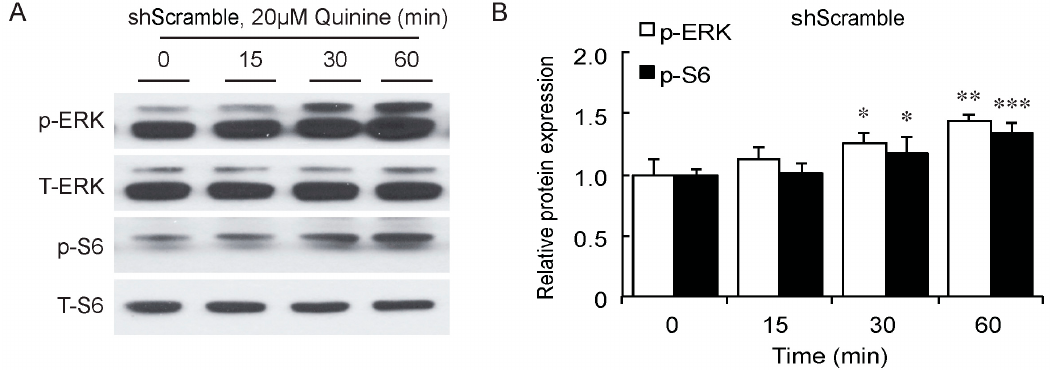
Figure 7. Cont. Figure 7. Cont.